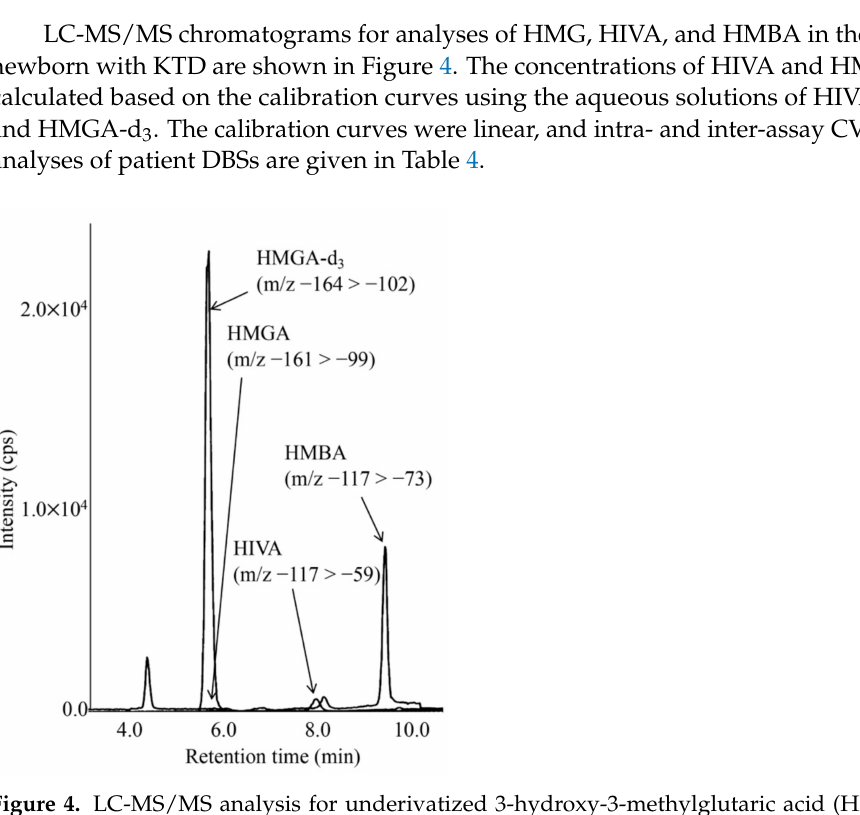
Figure 4. LC-MS/MS analysis for underivatized 3-hydroxy-3-methylglutaric acid (HMGA) and 3-hydroxyisovaleric acid (HIVA) using negative ion mode. The gradient elution program was as follows: 0% B (5 min), 0% to 38% B (6 min), 38% to 100% B (0.1 min), 100% B (5.9 min), 100% to 0% B (0.1 min), and 0% B (5